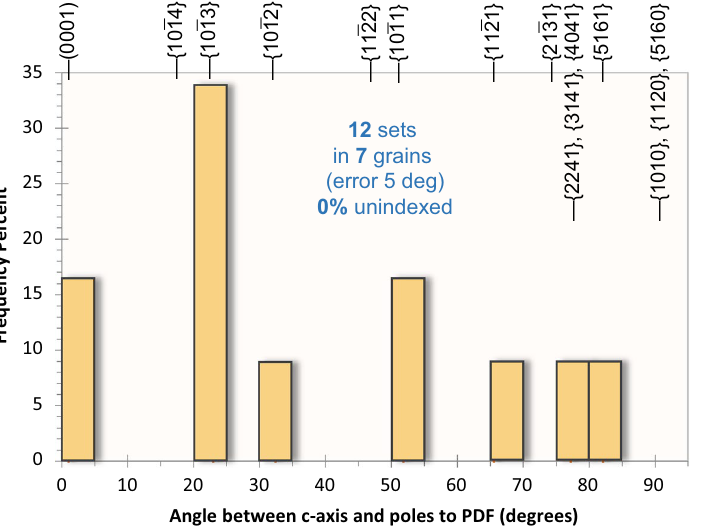
Figure 20. Sets of lamellae in shocked quartz grains. 7 TeH grains/crystallites display 12 sets of lamellae in 5° bins; no lamellae were unindexed. Two grains have a set of lamellae (0001) with its pole parallel to the c axis.